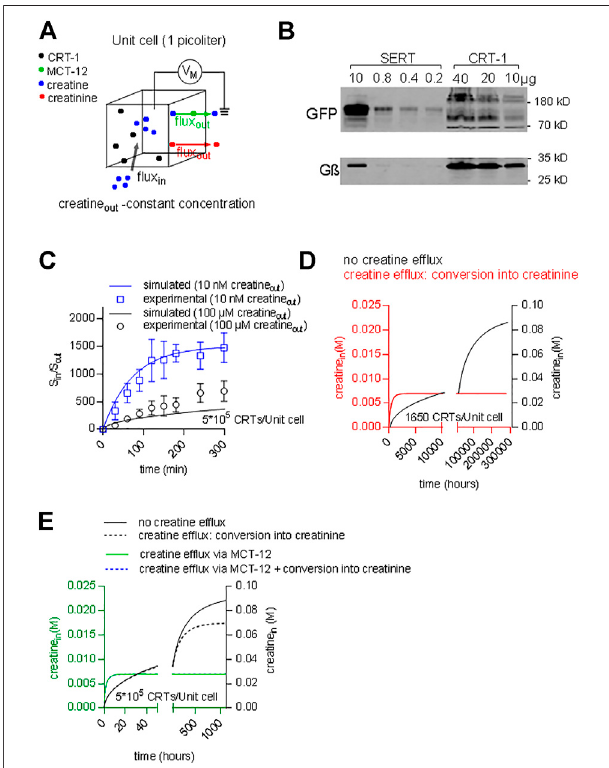
FIGURE 10 | Predicting time-dependent accumulation of creatine. (A) A hypothetical unit cell is depicted with a volume of 1 picoliter. The model posits that creatine (blue dots) can enter the interior of the cell only via CRT-1 (black dots; black arrow) and that intracellular creatine can escape from its con fi nement via two routes: 1) conversion into creatinine (red dots) and subsequent diffusion through the cellular membrane (red arrow) and 2) outwardlydirectedtransportofcreatineviaMCT-12(greendots;greenarrow). (B) Immunoblotting of CRT-1 transiently expressed in HEK293 cells: the membrane expression levels of YFP-tagged CRT-1 were compared to those in HEK293 cells, which had been stably transfected with a plasmid driving the expression of GFP-tagged SERT. The indicated amounts of membrane proteins were applied onto a denaturing gel, electrophoretically resolved and transferred to nitrocellulose. The transporter levels were detected by an antibodyrecognizing GFP and YFP; asaloading control, Gprotein β -subunits were detected with an antibody directed against an N-terminal sequence present in all G protein β -subunits. (C) The ratio of S in /S out (i.e., concentrative power) as a function of time: the time-dependent accumulation of creatine was determined in HEK293 cells, which had been transiently transfected with